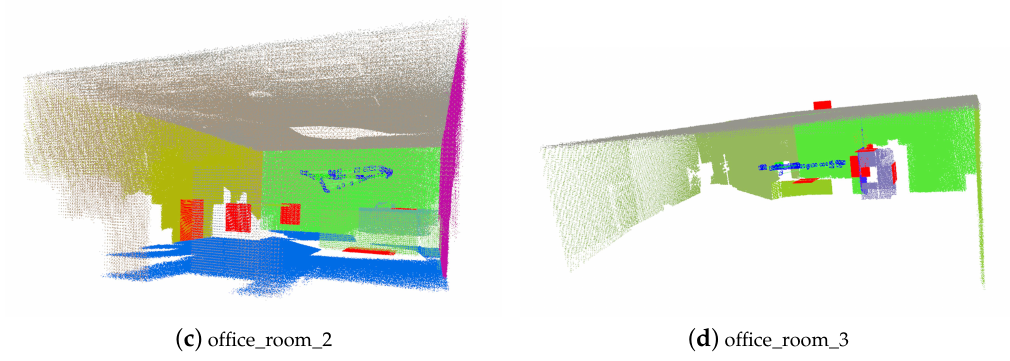
Figure 6. Supposed planes generated in the tracking process. Red planes denote supposed planes.